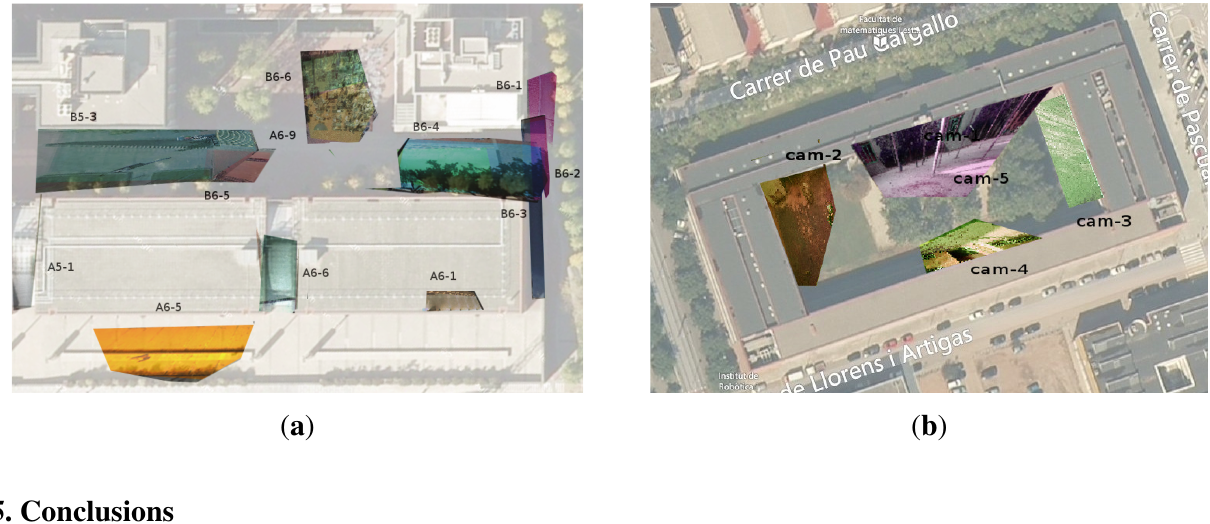
Figure 14. Computed homographies for the two scenarios. ( a ) BRL scenario; ( b ) FME